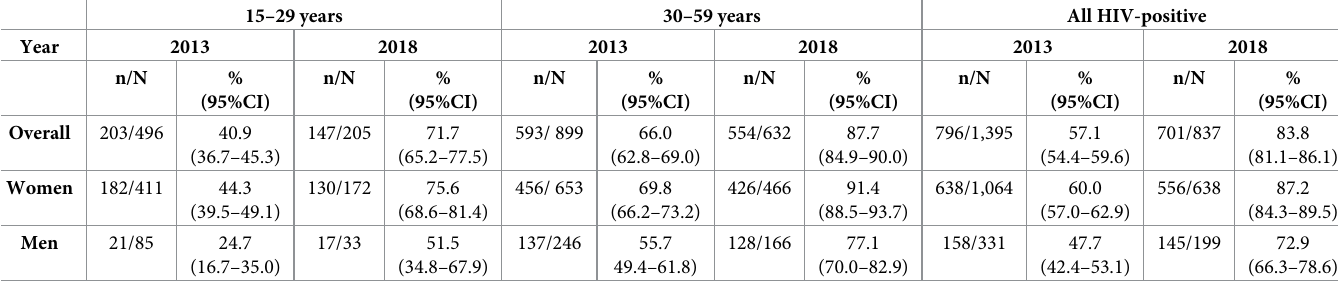
Table 2. Viral load supression (VL < 1,000 copies/ml) among all hiv-positive participants, by sex and age group, 2013 and 2018 surveys.